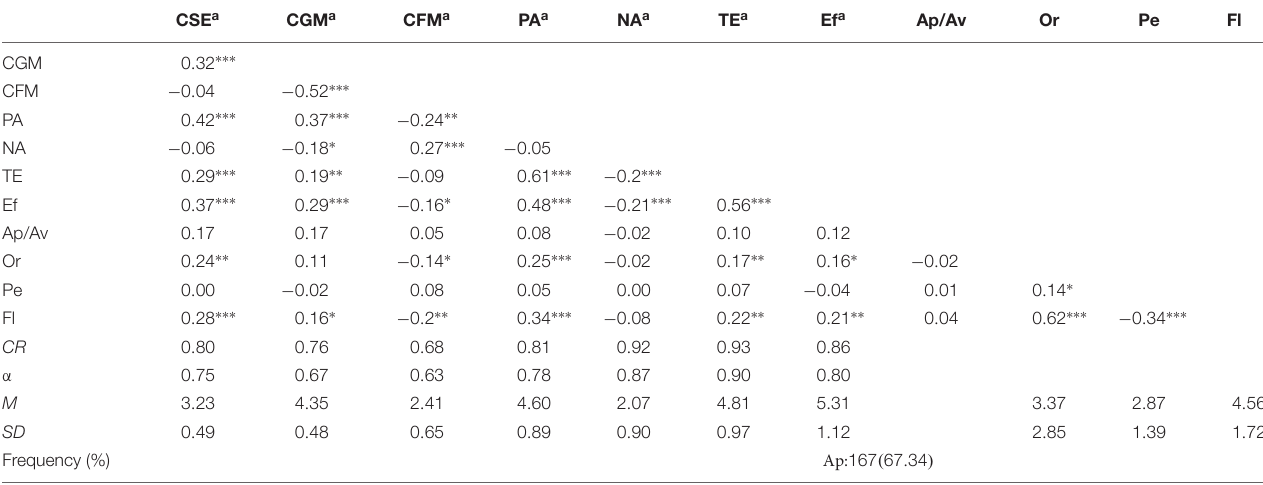
TABLE 1 | Descriptive statistics, reliability coefficients, and correlations for Study